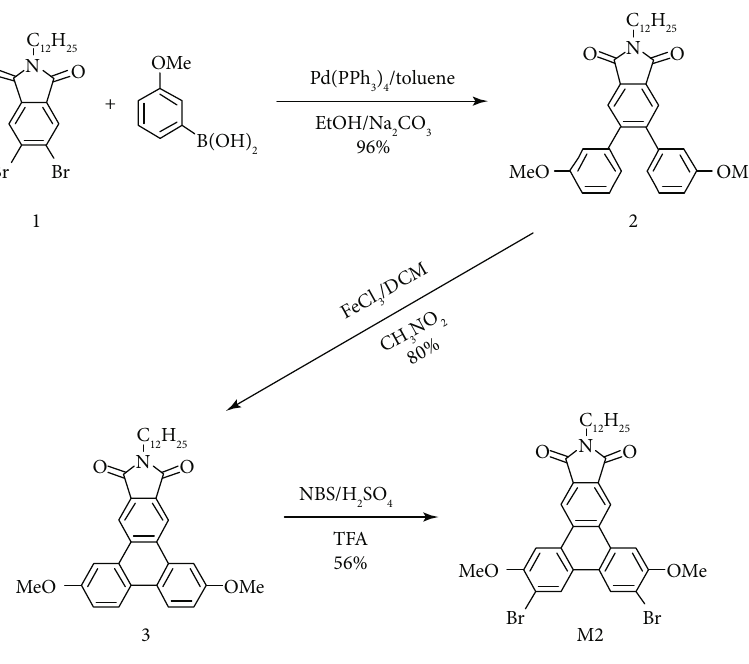
Scheme 1: Synthetic route of monomer M2